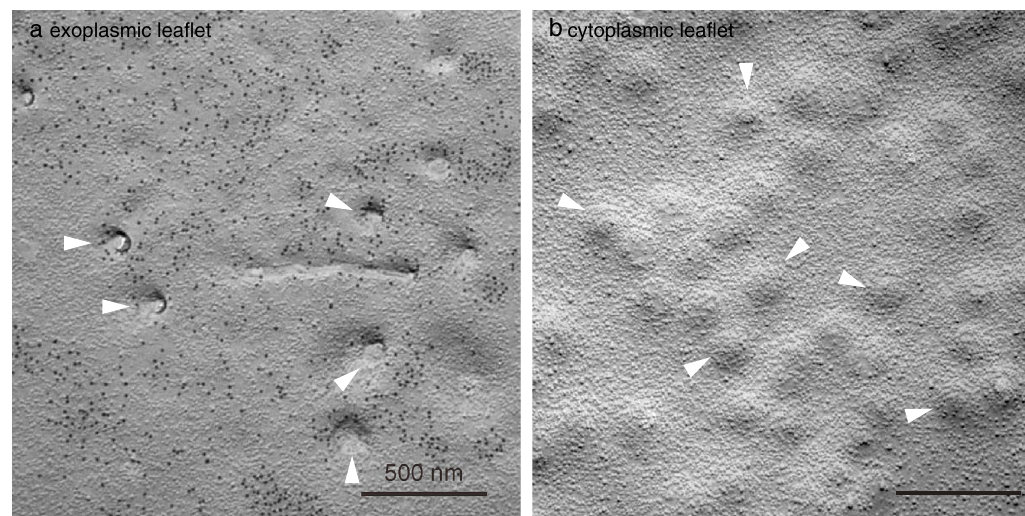
Figure 7. The expression of GM3 in the EF, but not the PF, of the uninfected and infected human erythrocyte plasma membrane. Freeze-fracture replicas of the erythrocyte were labeled by anti-GM3 antibody and colloidal gold (10 nm)-conjugated anti-mouse IgM antibody. ( A ) In the uninfected erythrocyte, GM3 labeling by 10 nm colloidal gold particles was detected in the EF of the freeze-fractured plasma membrane ( a , b ). The PF of the plasma membrane was unlabeled ( c ). The cell boundary is marked by arrowheads ( a ). The two rectangles in ( A ) are magnified in ( b ) (EF) and ( c) (PF). The average ( B ) and scatter diagram ( C ) of gold labeling density of GM3 on both the PF and the EF of the plasma membrane showed a wide range for each sample on the EF. Pink lines in C indicate the median of each data. ( D ) In the infected erythrocyte plasma membrane, the knobs were clearly observed as indentations on the EF (arrowheads in a ) or protrusions on the PF (arrowheads in b ). As in the uninfected erythrocyte plasma membrane, the labeling of GM3 was detected on the EF ( a ), but not the PF ( b ) in the infected erythrocyte plasma membrane. Scale bars: 500 nm ( Aa , D ) and 200 nm ( Ab , Ac